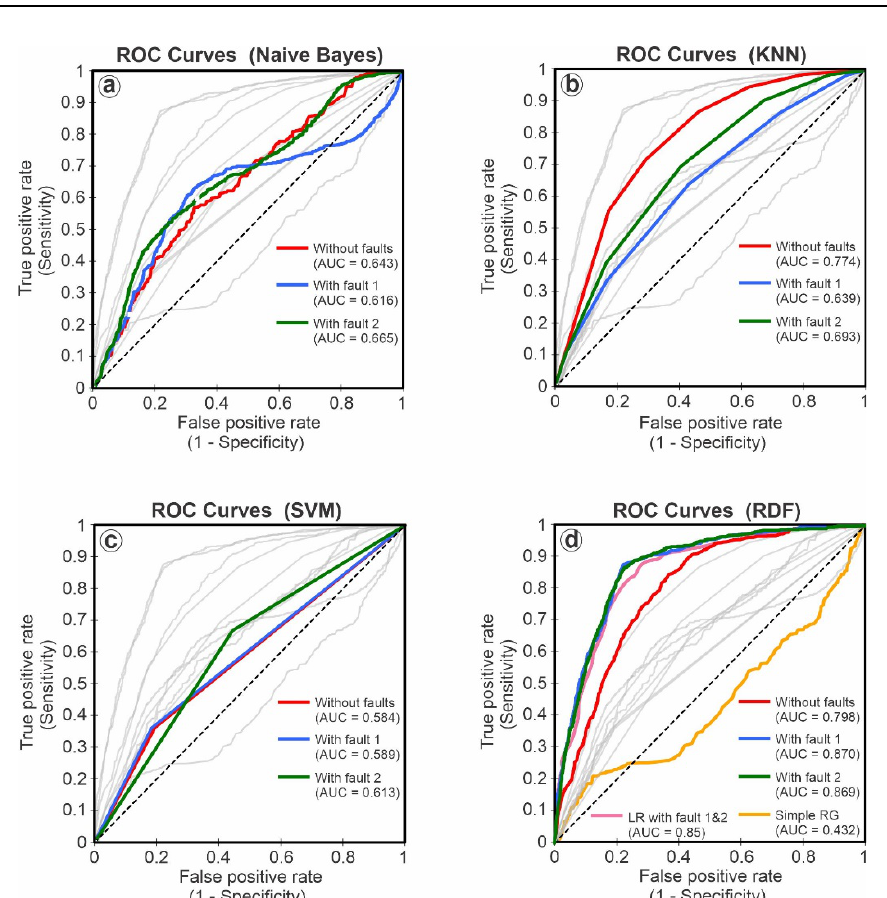
Figure 6. ( a )–( d ) ROC curves of the different classifiers. For the red curves, the Euclidean distances of the faults from the aftershocks were ignored. For the blue curves, the Euclidean distance of fault 1 was considered. For the green line, the Euclidean distance of fault 2 was considered. The gray curves in each figure show the ROC curves of the other classifiers. The pink and yellow curves in ( d ) indicate the ROC curve of the logistic regression and simple regression methods, respectively.